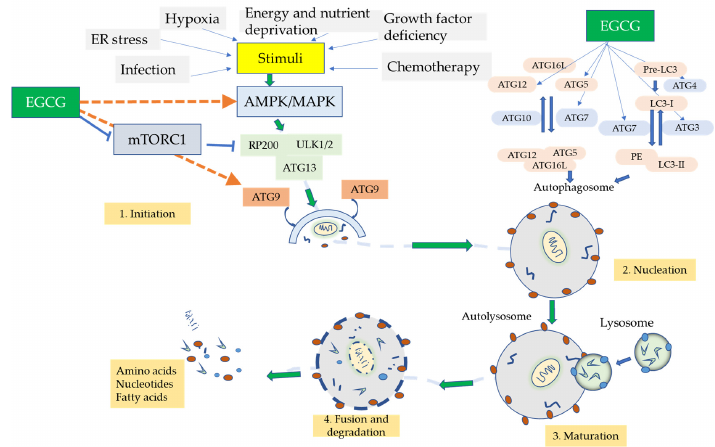
Figure 4. Proposed mechanism of EGCG autophagic response. Autophagy is a molecular recycling system explored extensively in cancer research. The promotion of molecular insults, i.e., ER stress, hypoxia, and chemotherapy, initiate the AMPK or MAPK/AKT/mTOR pathway, which recruits downstream effector protein kinases Unc-51 like autophagy activating kinase (ULK1/2,) and RP200 leading to the cascade of events leading to degradation of cellular debris. EGCG can act via AMPK or MTORC1 and act indirectly on autophagic-like proteins (ATG9) and ATG-9-15 to induce the autophagic series of events resulting in cellular debris breakdown and leading to the residue being reused for proper cellular growth and